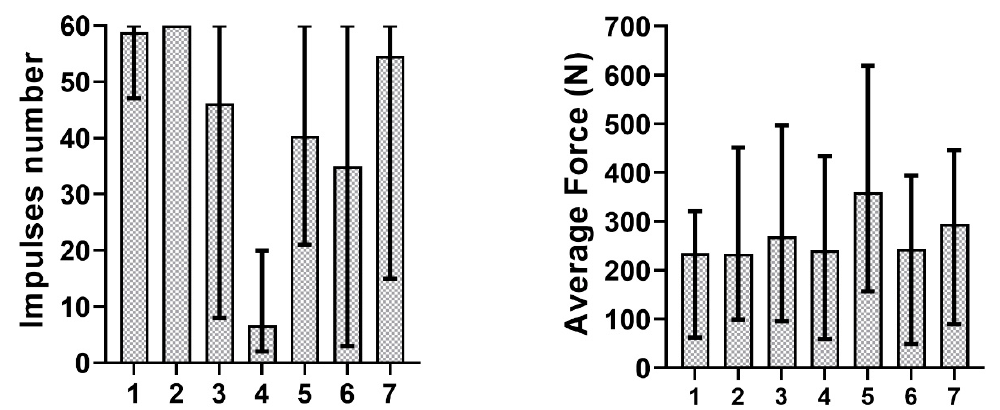
Figure 7. Bridge influence on impulses number and average force.